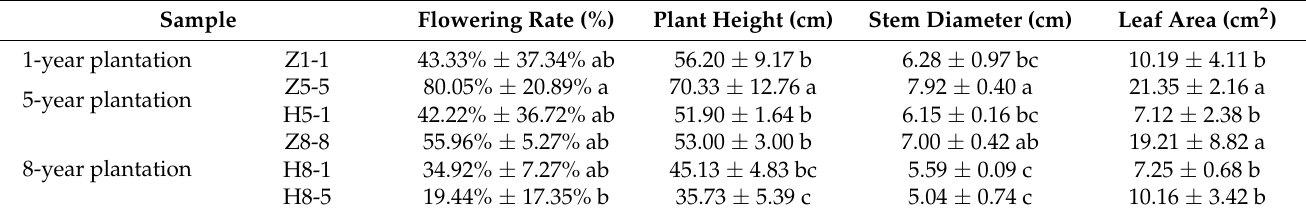
Table 1. Morphological indices of herbaceous peony under different planting and replanting years.